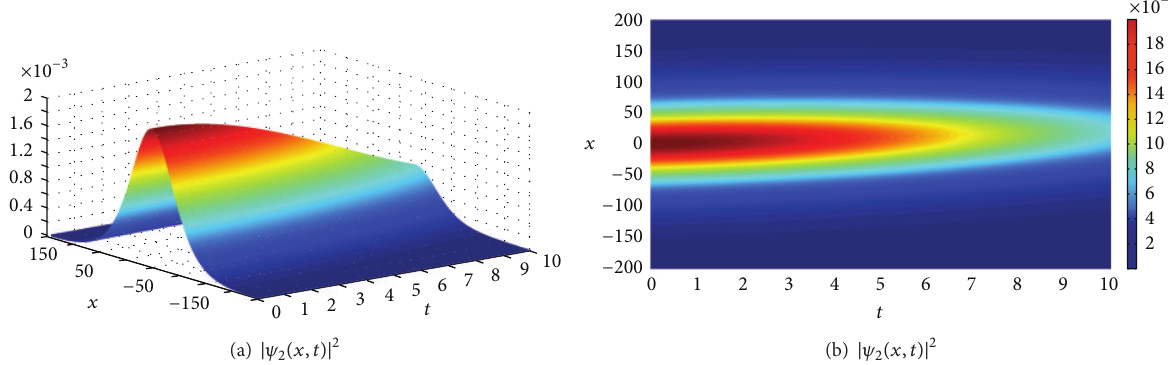
Figure 2: Density distributions of the matter-wave soliton solution 𝜓 2 (𝑥, 𝑡) :(a) the three-dimensional density distribution and (b) the contour profile.